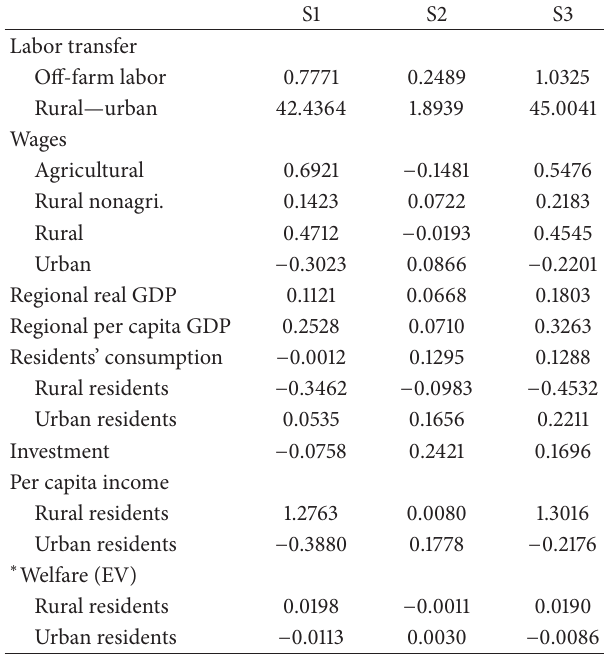
Table 4: Results of policy simulations in 2015 (% change, 𝜎 ag = 2.67